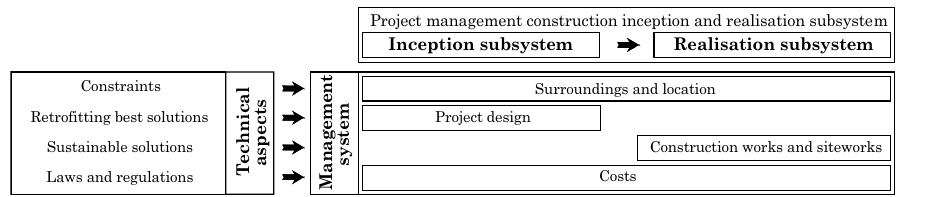
Fig. 2. Organizational diagram of the management system